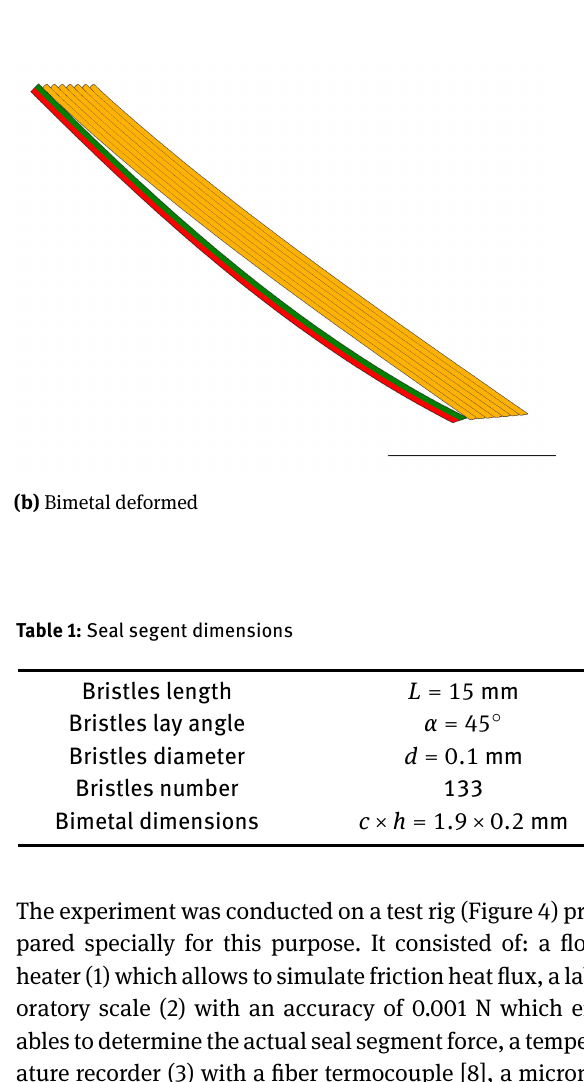
The dimensions of seal segment are listed in Table 1. The bristles are made of Haynes 25, the most common brush seal alloy, and the bimetal is TB208/110 [1] com- monly used as a thermostatic element.